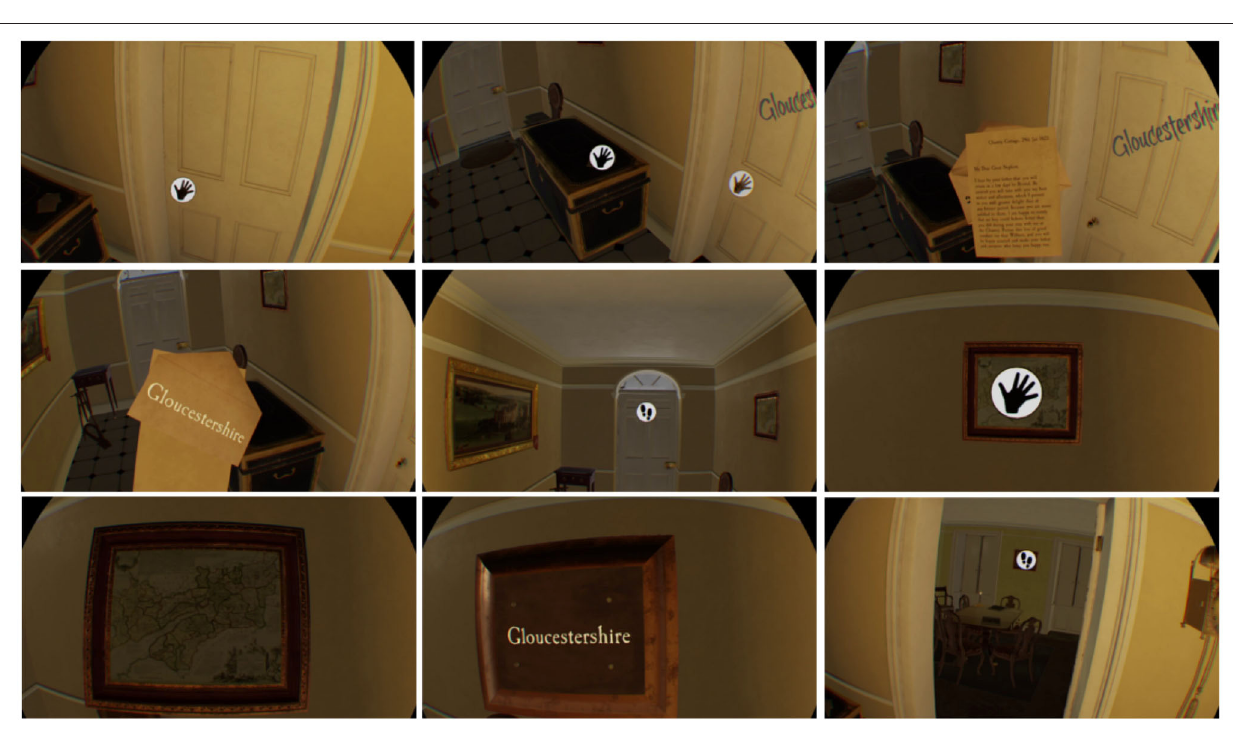
FIGURE 4 | The actions taken to complete the “ Gloucestershire ” task in “ the Chantry .” The door is closed until the player navigates toward two items, picks them up, and turns them over to reveal the word on the